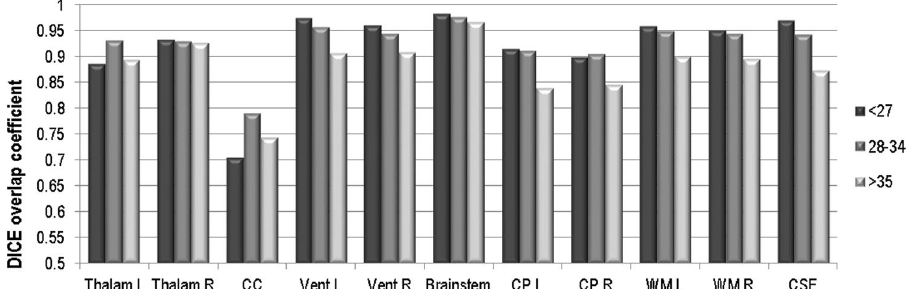
Figure 8. DSC metrics computed for brain tissue and structures for leave-one-out automatic multi-atlas segmentation evaluation applied to seven subjects with reference manual segmentations (the test set), averaged in three GA ranges: less than 27 weeks, between 28 and 34 weeks, and more than 35 weeks. Overall, the results indicated that relatively accurate automatic segmentation of the main brain structures and tissue were achieved by using the developed spatiotemporal fetal brain MRI atlas, symmetric diffeomorphic deformable registration for label propagation 60 , and probabilistic STAPLE 65 for label fusion. Labels are: Thalam L: left thalamus, Thalam R: right thalamus, CC: corpus callosum, Vent L: left lateral ventricle, Vent R: right lateral ventricle, Brainstem, CP L: left cortical plate, CP R: right cortical plate, WM L: left developing white matter, WM R: right developing white matter, and CSF: cerebrospinal